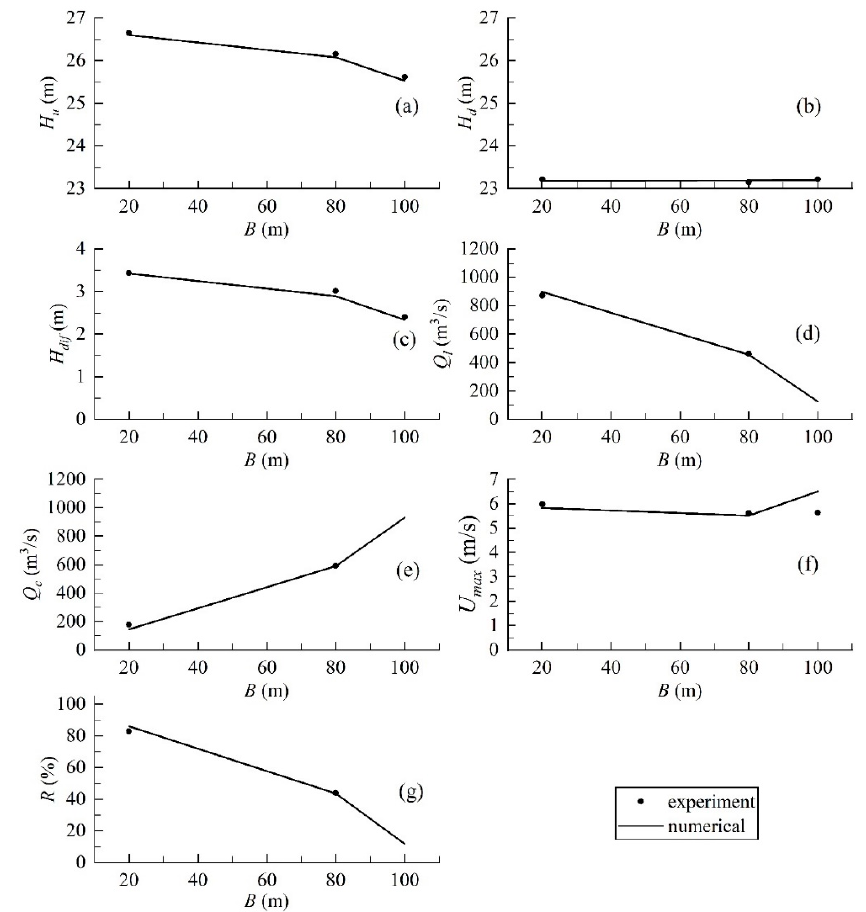
Figure 8. Comparison between numerical results and experimental data under working condition 2: ( a ) upstream water level; ( b ) downstream water level; ( c ) water level difference; ( d ) flow rate of low holes; ( e ) flow rate of closure gap; ( f ) maximum velocity; ( g ) split flow rate .